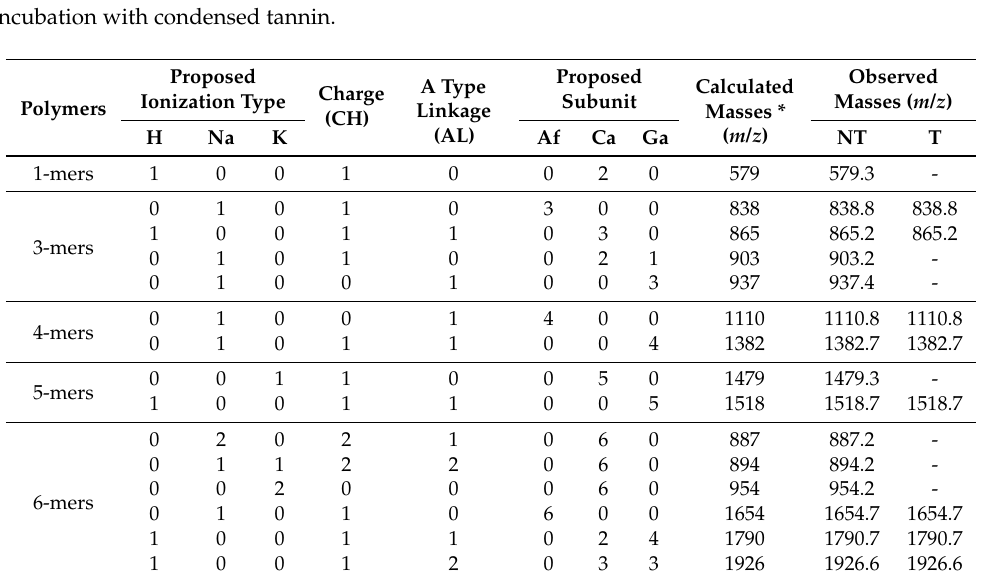
Figure 4. ESI-TOF-MS spectra of condensed tannin from LPP. ( A ) Control; and ( B ) A. awamori -treated condensed tannin. Table 1. The proposed subunits of litchi pericarp condensed tannin and the changes after A. awamori incubation with condensed tannin.